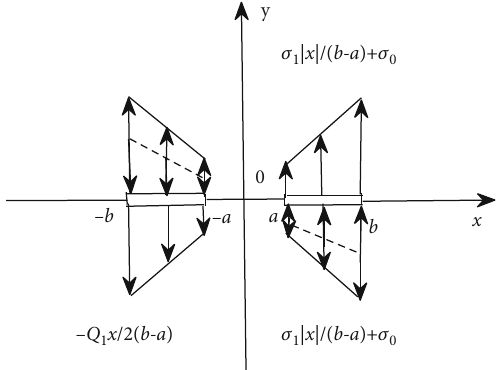
Figure 1: Two collinear cracks subject to linear thermal fl ux and linear mechanical